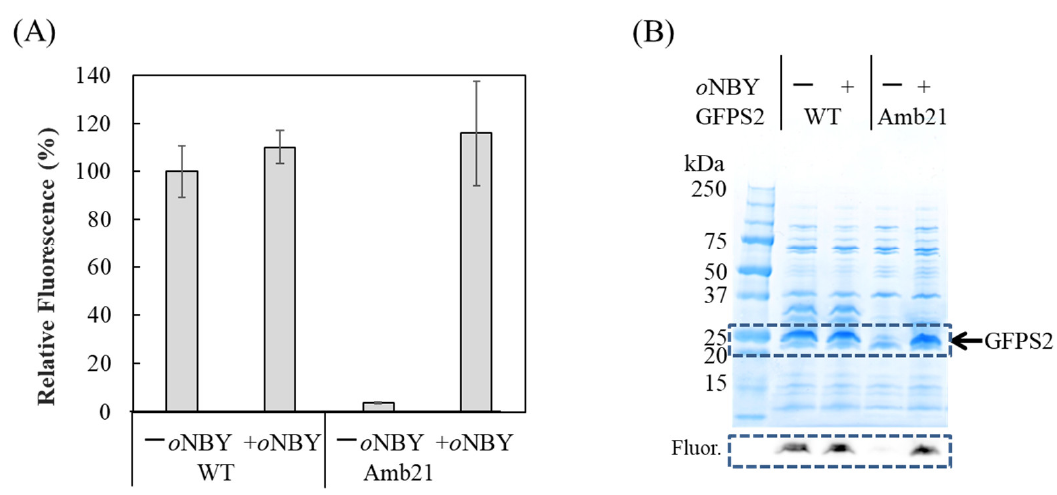
Figure 3. Cell-free protein synthesis of N11-GFPS2 with (+) or without (−) o -nitrobenzyl Tyr ( o NBY) supplementation using the cell extract from the strain B95.deltaA. Wild-type GFPS2 is indicated as “WT” and GFPS2 with Y21amber mutation is indicated as “Amb21”. ( A ) Fluorescent measurement of GFP in the reaction solutions. The excitation and emission wavelengths are 485 nm and 535 nm, respectively. Data represent the mean ± standard deviation (SD) of four independent experiments; ( B ) SDS-PAGE analysis of fractions purified by Ni-NTA resin. The 10–20% polyacrylamide gel was stained with CBB after electrophoresis. A portion of a fluorescent image of the gel framed by the dashed line is shown in the lower panel. The fluorescent imaging was performed by Vilber Bio Im- aging FUSION FX with 470 nm and 535 nm filters. Molecular weights of protein standards (BIO- RAD Cat. No. 1610363) are indicated. 2.4. Crystallization of Caged Lysozyme and Decaging in the Crystal To investigate the application of caged proteins to X-ray crystallographic study, we synthesized hen egg-white lysozyme (HEWL) with an o NBTyr substitution for Tyr20 (HEWL_Y20 o NBTyr) by using the aforementioned E. coli cell-free protein synthesis sys- tem [24,25]. HEWL_Y20 o NBTyr was purified from the cell-free reaction solution and crys- tallized using the sitting drop vapor diffusion method. The HEWL_Y20 o NBTyr crystals yielded datasets at 1.44 Å resolution with completeness of 99.6% and a CC 1/2 of 0.980. Model building and structure refinement were performed using Phenix (Table S1, PDB ID: 7YNU) [26]. The crystal structure of HEWL_Y20 o NBTyr contained one protomer in the asymmetric unit (Figure 4A). Comparison of the HEWL_Y20 o NBTyr structure with that of the wild-type lysozyme (PDB ID: 3WUL) shows that these structures are almost the same (RMSD, 0.202 Å) [27]. We observed a continuous density from the tyrosine resi- due at position 20, in which the nitrobenzyl group could be unambiguously modeled (Fig- ure 4B). The density corresponding to the distal part of o NBTyr appeared somewhat weak, and the occupancy for atoms of the nitrobenzyl group is relatively low (0.5–1.0). This could be caused by the structure flexibility, as with o NPTyr (PDB ID: 6rtz) [9]. The tyrosyl moiety of o NBTyr20 is stabilized by the stacking interactions between Arg21 and Lys96 and the hydrogen bonding with Ser100 (Figure S3). On the other hand, the nitrobenzyl group forms an electrostatic interaction with Arg21, but is exposed on the surface (Figure S3A). Furthermore, the molecular geometry at this position does not affect the crystal packing environment. Alternatively, light contamination during protein synthesis or pu- rification may have caused slight damage to the caged structure. These results confirm that efficient cell-free production of lysozyme with o NBTyr does not occur with any non- specific suppression of the UAG codon with natural amino acids in the cell-free synthesis reaction. Finally, the crystals were irradiated with 365 nm light for 5 min for decaging. The obtained crystal structure at a 1.4 Å resolution showed that o NBTyr efficiently de- graded into Tyr (Figure 4C,D). The overall structure of decaged HEWL was almost iden- tical to that of caged HEWL. The RMSD per residue between structures before and after